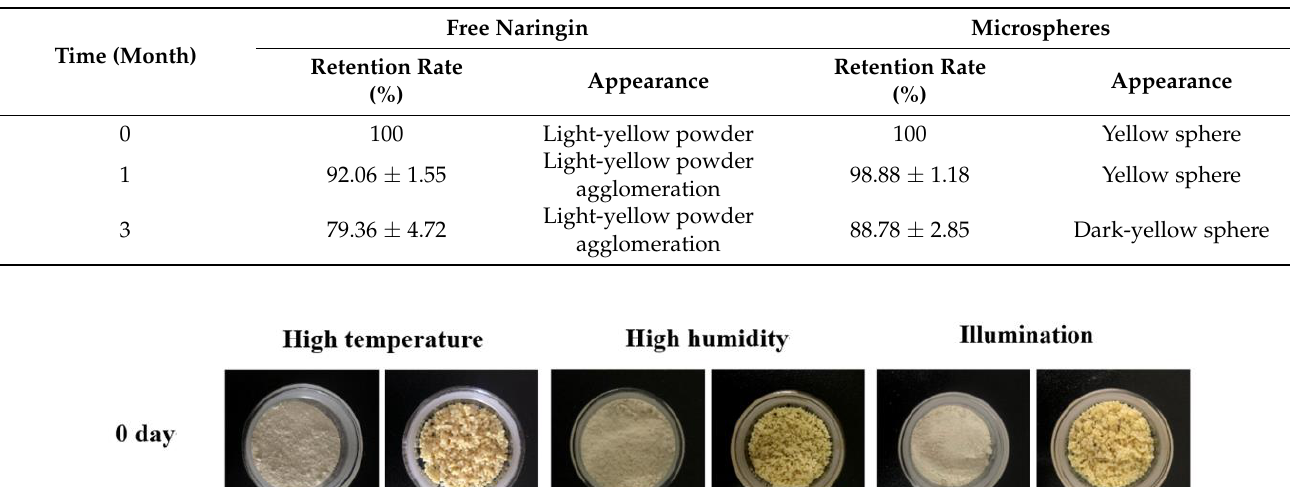
Table 3. Stability of naringin loaded on microspheres and free naringin under storage environments for 3 months ( n = 3).